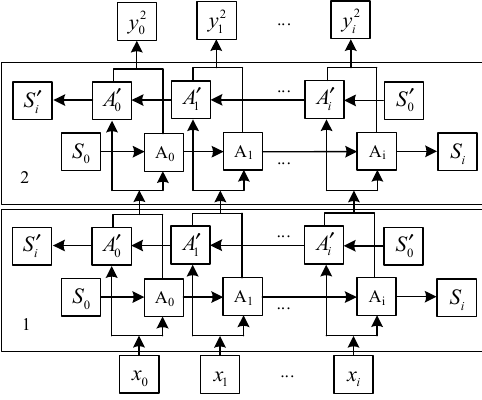
Figure 4. BLSTM structure diagram of two floors.